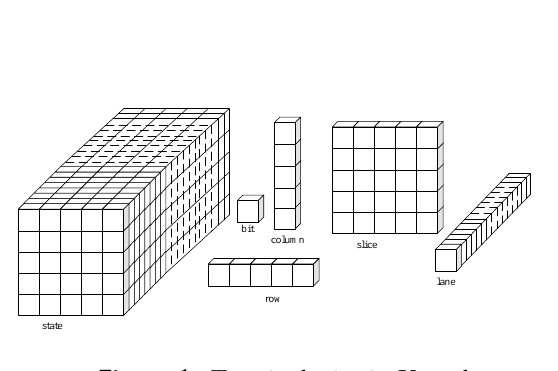
Figure 1: Terminologies in